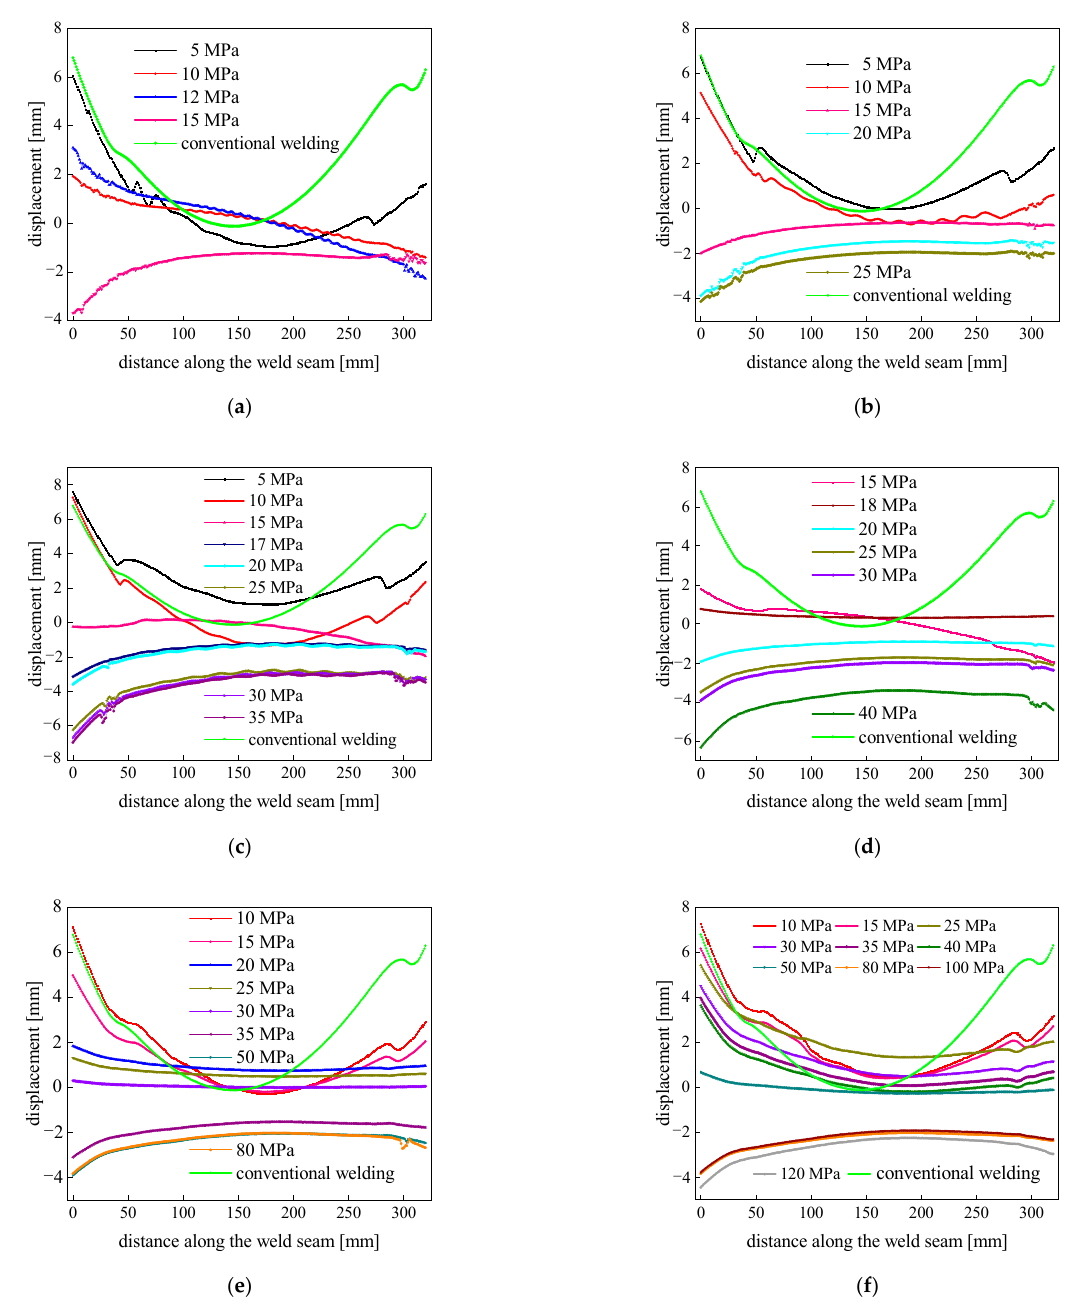
Figure 9. Distortion diagram of thin plates under different loading distances: ( a ) d = 12; ( b ) d = 16; ( c ) d = 20; ( d ) d = 24; ( e ) d = 28; ( f ) d = 32 mm.